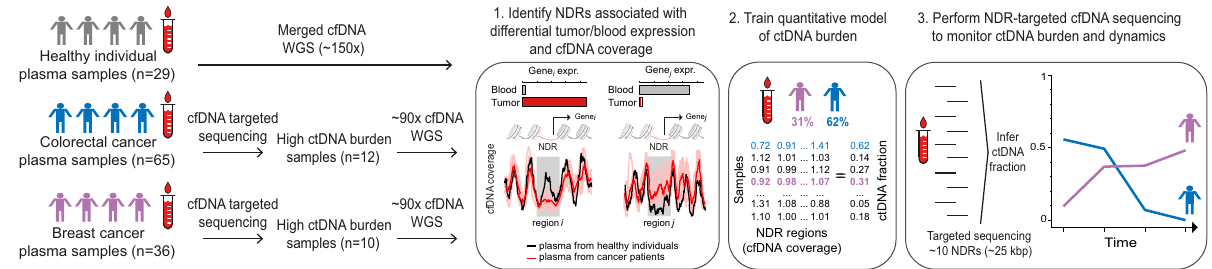
Fig. 1 Overview of approach. Deep cfDNA WGS pro fi les of plasma samples from healthy individuals and cancer patients were compared to identify nucleosome-depleted regions (NDRs) with tumor/blood tissue-speci fi c expression and differential cfDNA coverage. A model was trained to predict ctDNA levels from NDR cfDNA coverage. A compact assay targeting predictive NDRs was used to perform longitudinal pro fi ling of ctDNA levels and dynamics.